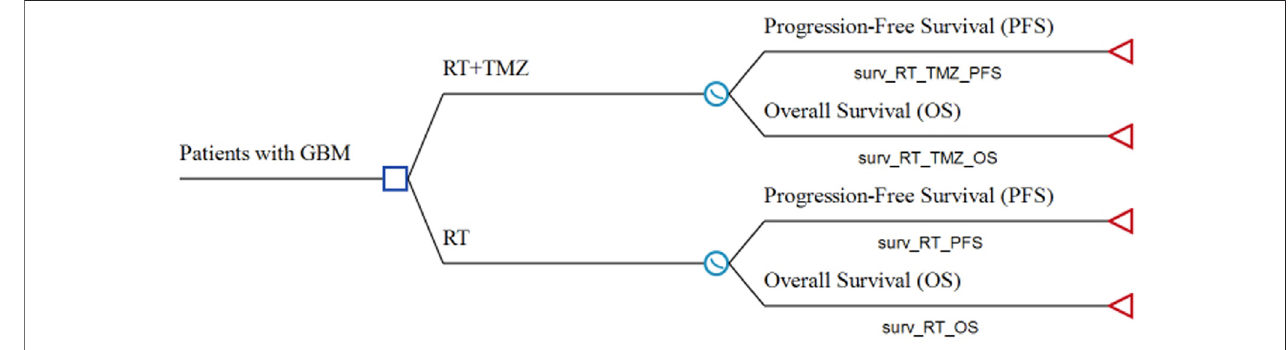
FIGURE1| ModelstructureofadecisiontreecombiningthepartitionedsurvivalmodelGBM:glioblastoma;OS:overallsurvival;PFS:progression-freesurvival;RT: radiotherapy; TMZ: temozolomide.